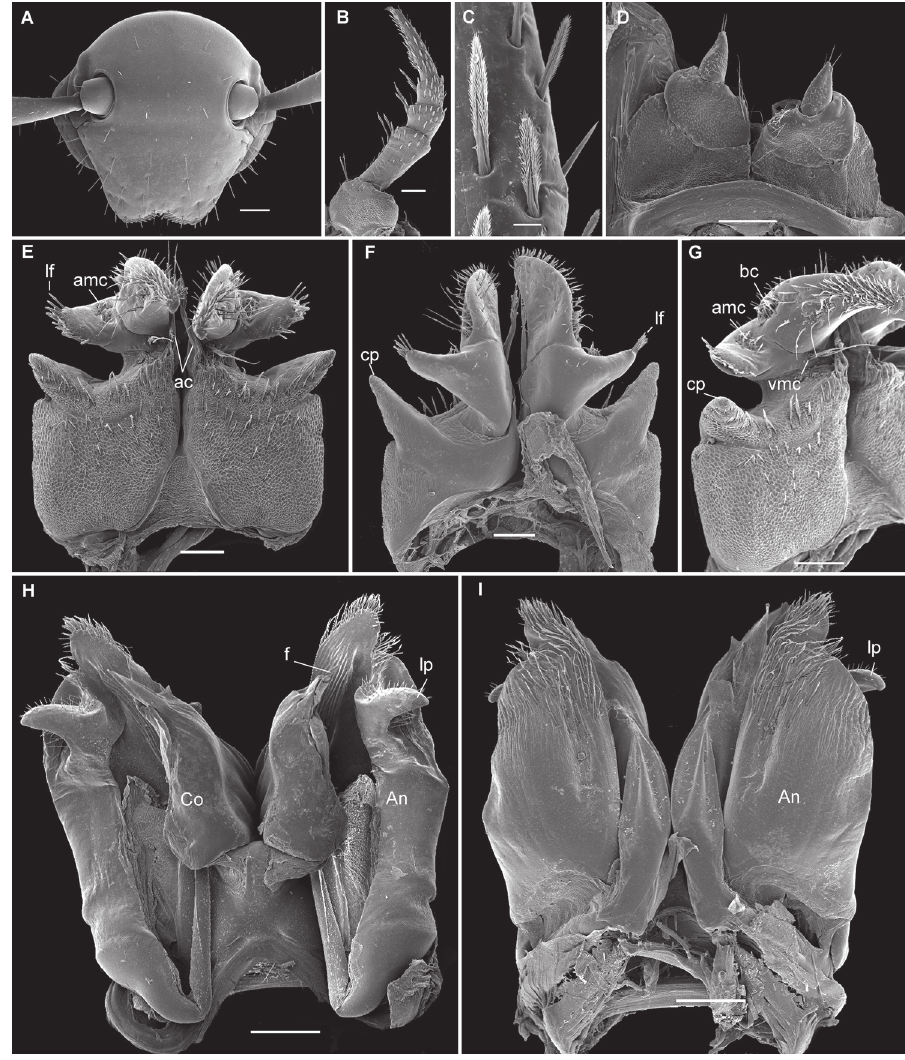
Figure 1. Stemmiulus ongot Nzoko Fiemapong & VandenSpiegel, sp. n. ♂ paratype (SEM) . A head front view B first leg-pair (one); C detail of the spatulate setae on the first leg-pair D leg-pairs 9 (parago- nopods) oral view E, F, G leg-pair two, caudal, oral and latero-caudal views, respectively H, I leg-pair 8 (gonopods) caudal and oral views, respectively. Abbreviations: ac : apicolateral cluster of elongated setae, An : angiocoxite, amc : apicomedial cluster of setae, bc : basal cluster of setae, cp : conical projection, Co : colpocoxite, f : flagella, lf : lateral fringe of setae, lp : subterminal process, vmc : ventromedial cluster of setae, Scale bars 200 µm ( A, H, I ), 100 µm ( B, D–G ), 10 µm ( C ). Gonopod structure (Fig. 1H, I) typical of the genus, angiocoxite with a small, pro- jecting, subapicolateral process. Apex of colpocoxite simple, with neither a lobe nor a projection surrounding the flagella (Fig.